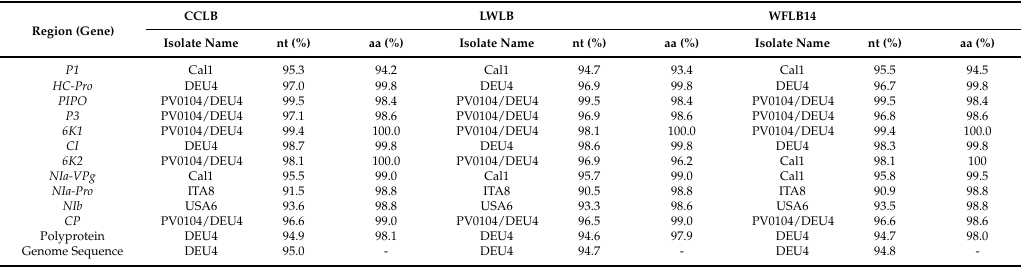
Table 2. Highest identities of individual CCLB, LWLB and WFLB14 genes with other TuMV isolates at nucleotide (nt) and amino acid (aa)